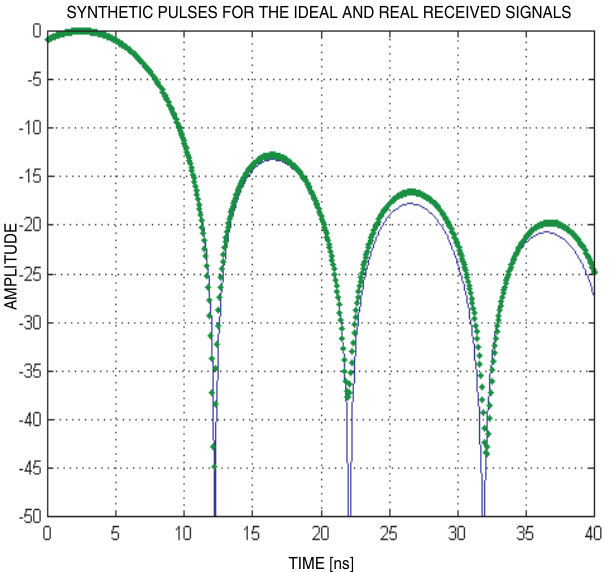
Fig. 13. Comparison of theoretical and received synthetic pulses making use of the stepped frequency signal on the «worst band» between 802 and 902